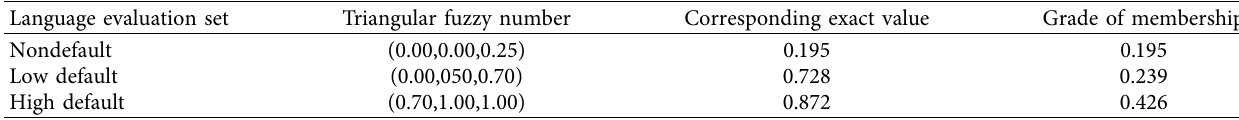
Table 3: Fuzzy language evaluation sets and corresponding